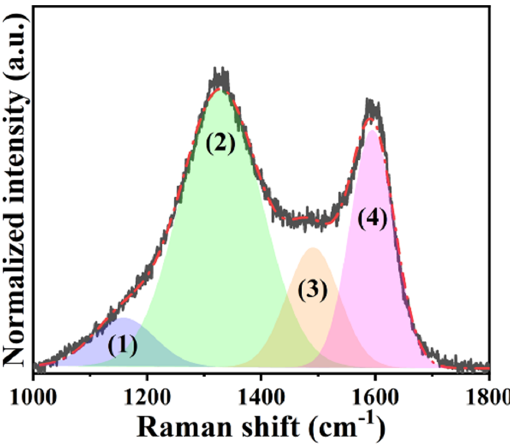
Figure 2. Fitted Raman spectrum of H@H composite material.